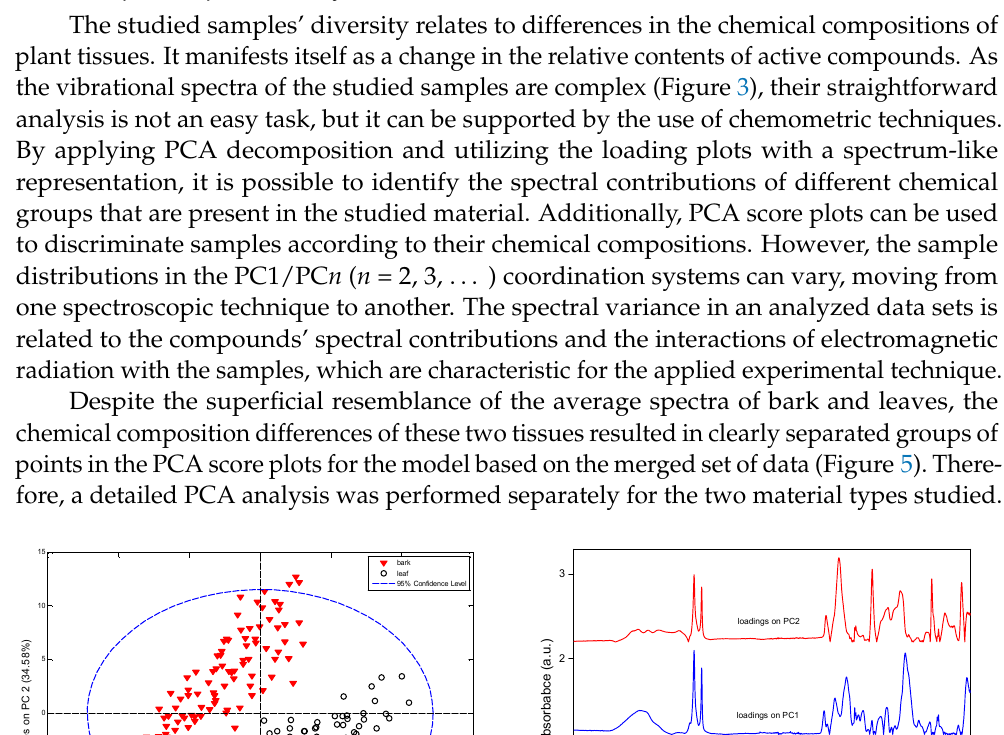
Figure 4. Raman spectra of poplar bark ( left ) and leaves ( right ) containing the maximal (a) and minimal (b) contents of salicylates, difference spectra (c), and the spectrum of salicin (d).